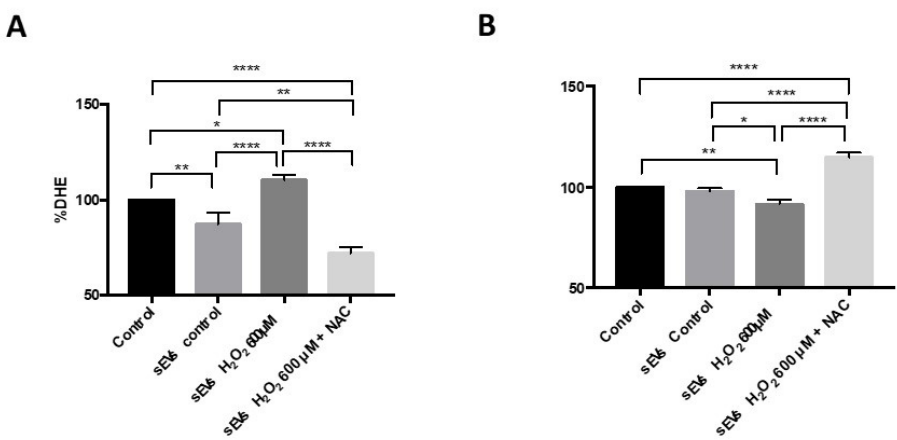
Figure 1. sEVs induced oxidative stress and affected cell viability. Superoxide anions were measured by DHE after sEV control (87.16 ± 6.23), sEV H 2 O 2 600 µ M (110.5 ± 2.61), and sEV H 2 O 2 600 µ M with N-acetylcysteine exposure (72.03 ± 6.61) ( A ). XTT assay was performed on the analyzed cell viability after sEV control (97.98 ± 1.58), sEV H 2 O 2 600 µM (91.38 ± 2.43), and sEV H 2 O 2 600 µM with N-acetylcysteine exposure (114.8 ± 2.31). ( B ). Values are expressed as percentage to control ± SEM ( n = 4; DHE and n = 3–4; XTT). The p -value was calculated by ANOVA, and statistically significant differences were * p < 0.05, ** p < 0.01, and **** p < 0.0001. sEVs 600 µM H 2 O 2 A